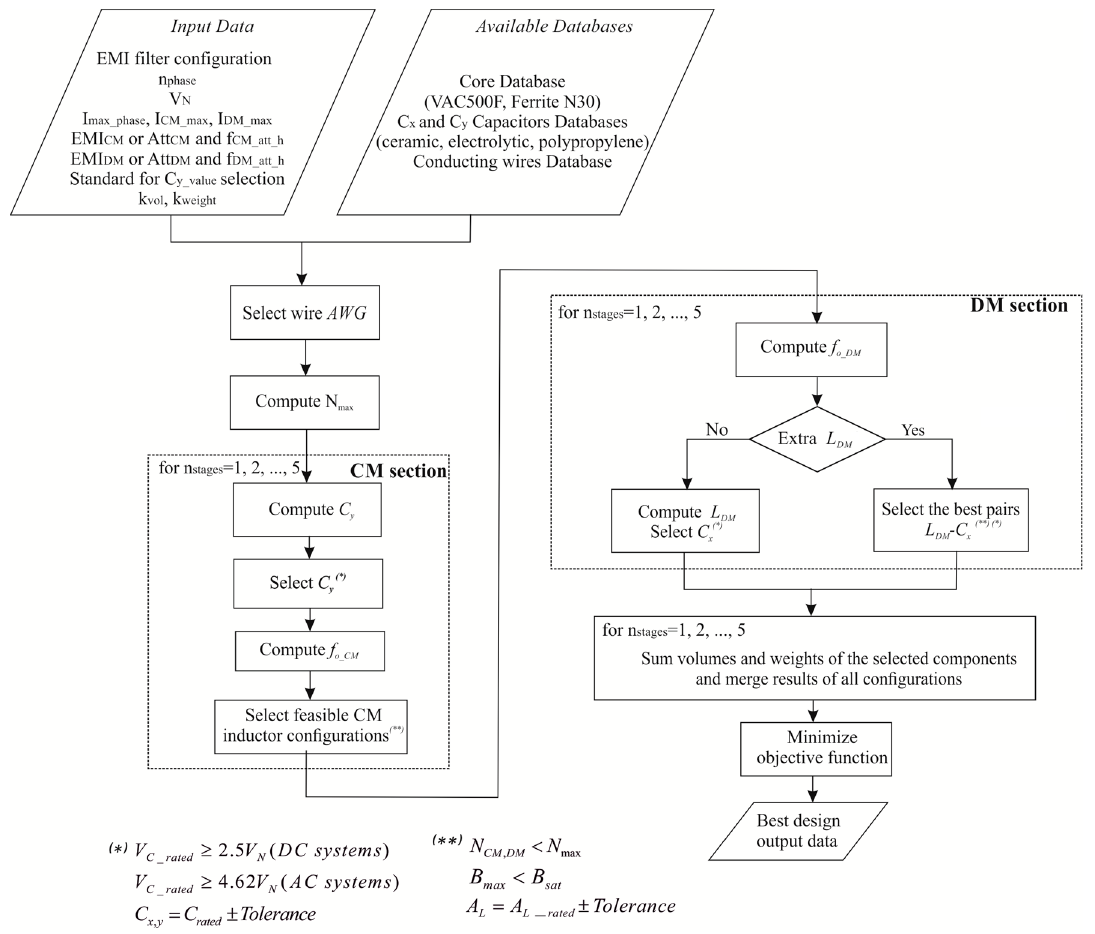
Figure 1. Flowchart of the proposed design method.